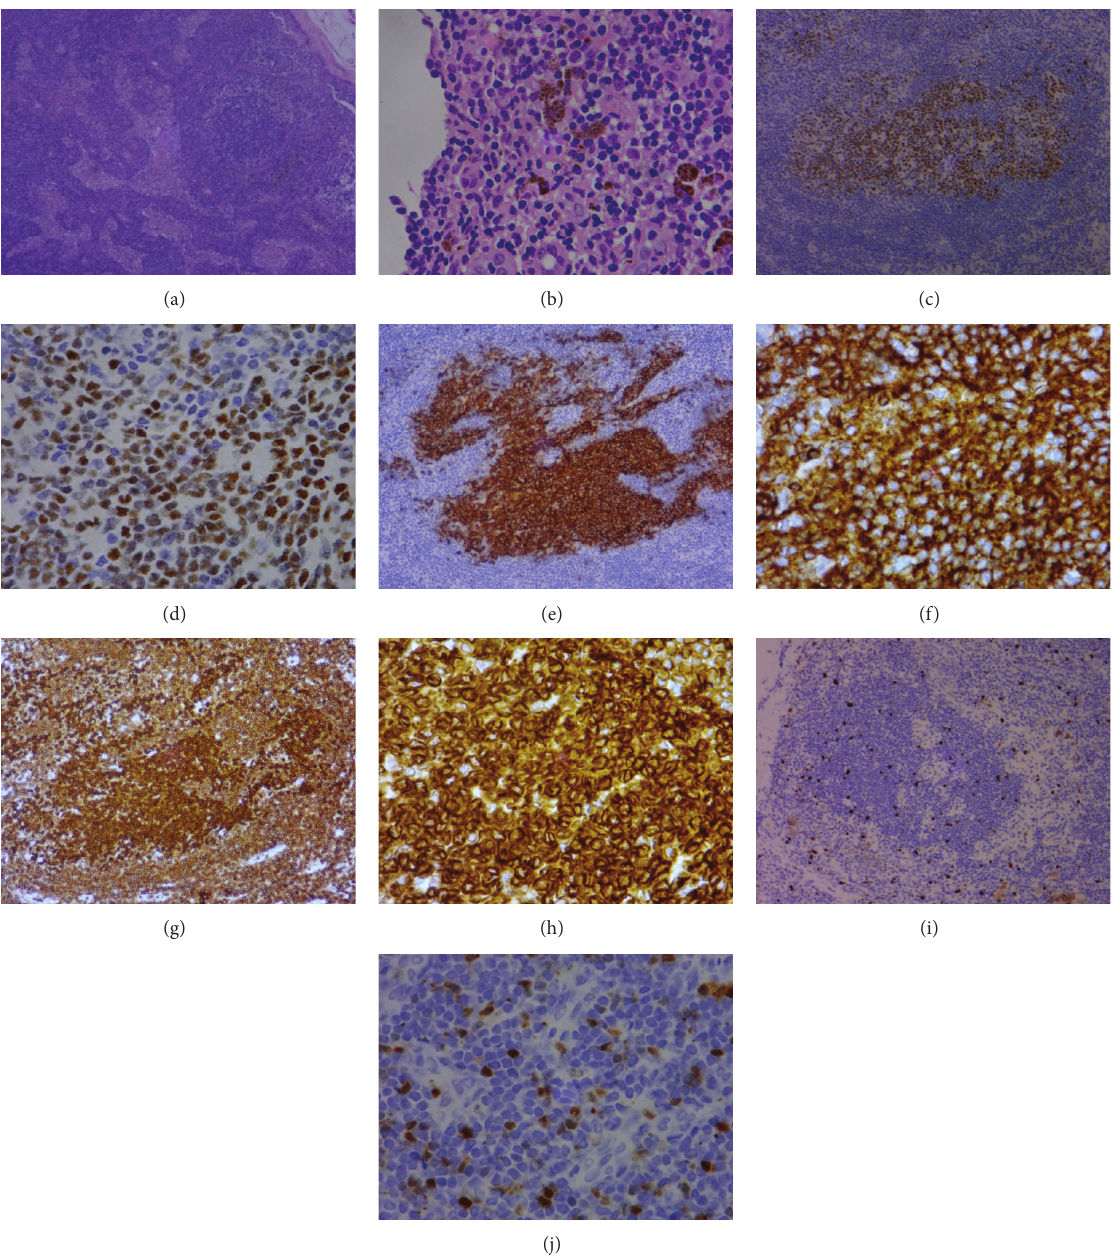
Figure 1: (a and b) H&E showing intact lymph node architecture, sinus histiocytosis, and patchy aggregates of melanophages ((a) × 10, (b) × 40). (c and d): Bcl-6 marking the follicular centre cells ((c) × 10, (d) × 40). (e and f): CD10 marking follicular centre cells ((e) × 10, (f) × 40). (g and h) Bcl-2 staining the cells within the germinal centres strongly ((a) × 10, (b) × 40). (i) Low Ki67 intensity. (j) Patchy S100 staining of interfollicular dendritic